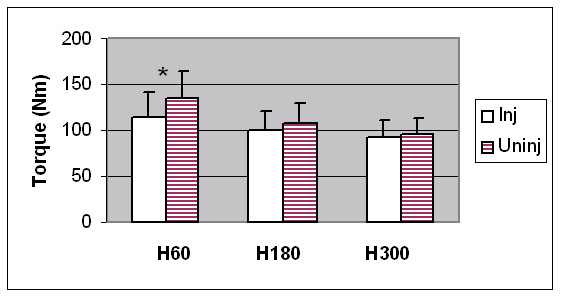
Comparison of hamstrings (H) average peak torque values between previously injured (Inj) (n = 13) and uninjured (Uninj) (n = 29) dominant limbs at 60°/sec, 180°/sec and 300°/sec. * indicates a statistically significant difference (p < 0.05).